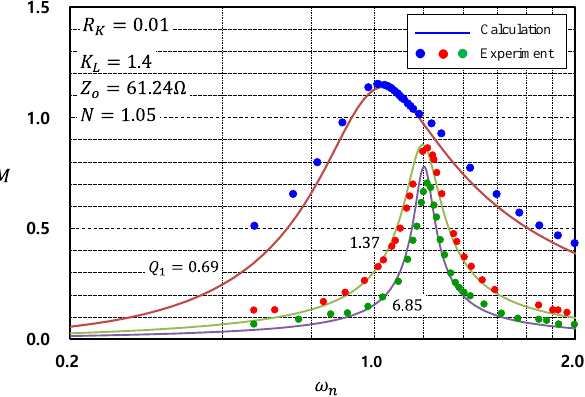
Figure 8. Frequency characteristics of the DC voltage gain M .